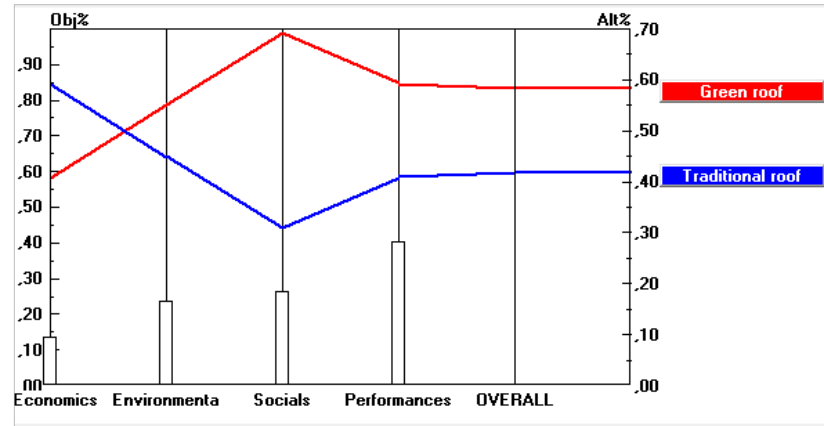
Figure 9. Professionals group. Results obtained from the Multi-Criteria Analysis (MCA) reported with respect to the groups of criteria (Obj%; ranges 0.00–0.90) and the scale of the final priority of the two roof alternative solutions (Alt%; ranges 0.00–0.70).